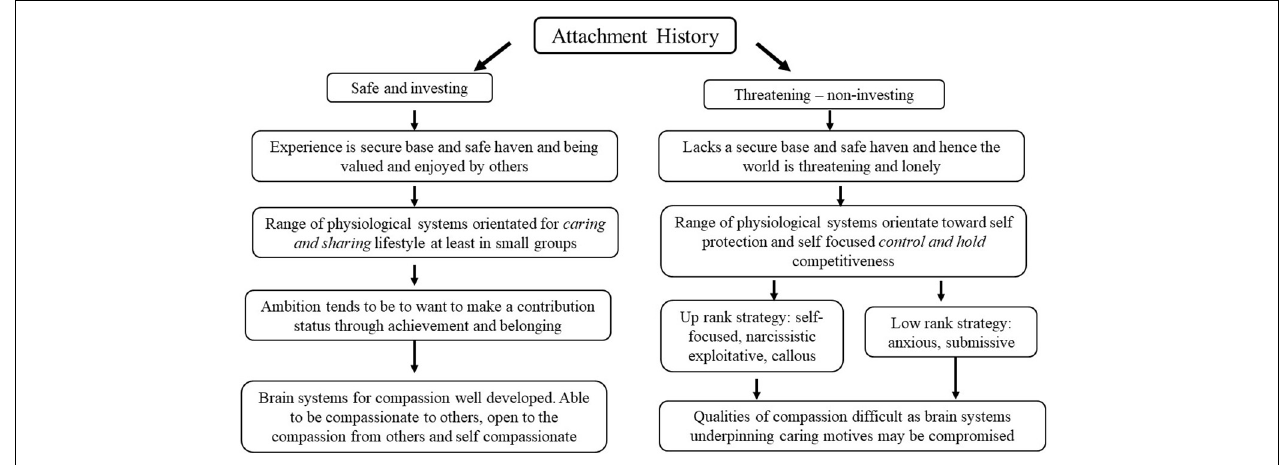
FIGURE 1 | Early life background and strategic orientation: Adapted from Gilbert (2005).